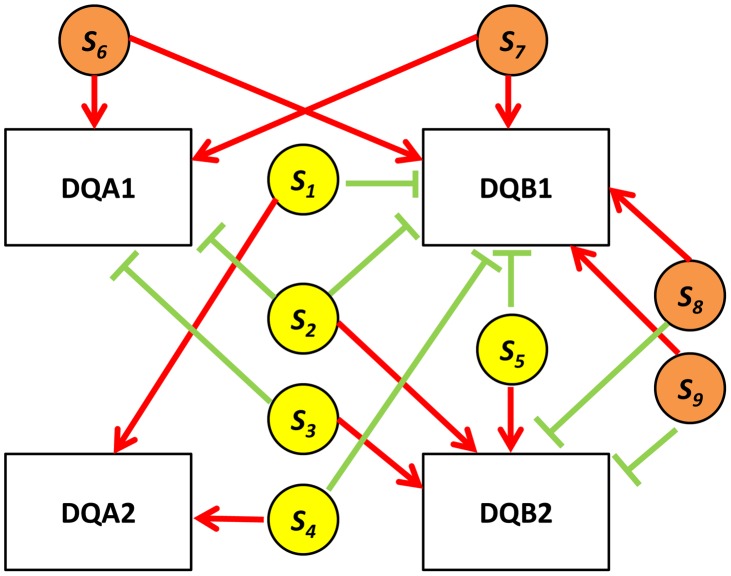
HLA quartet.An example of examining eSNP sources and gene targets on the same chromosome together. Assembled quartets at the HLA locus highlight a 9-SNP haplotype associated with co-expression of DQA1-DQB1 and anti-correlated to DQA2-DQB2. s1, s2, s3, s4 and s5 (yellow circles) correspond to rs2808143, rs1129740, rs9274634, rs9274389 and rs1142334 respectively. s6, s7, s8 and s9 (orange circles) correspond to rs8227, rs1130034, rs9272851 and rs1130116 respectively. Red edges indicate up-regulation, green edges indicate down-regulation.